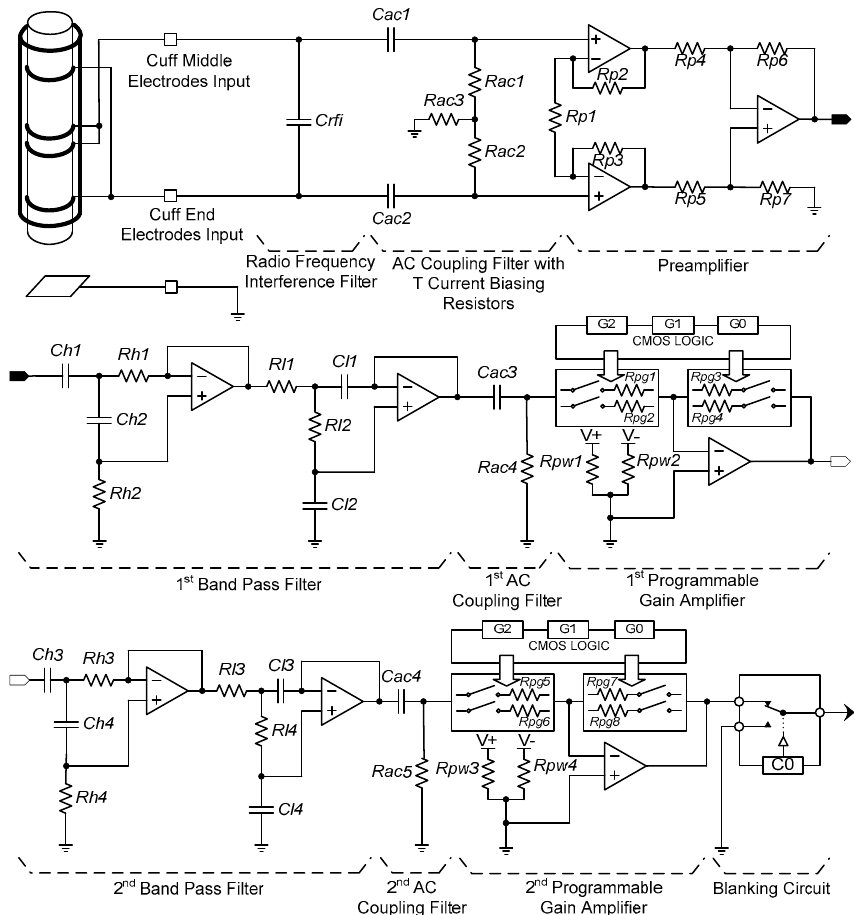
Figure 3. Block diagram of the proposed neural amplifier.